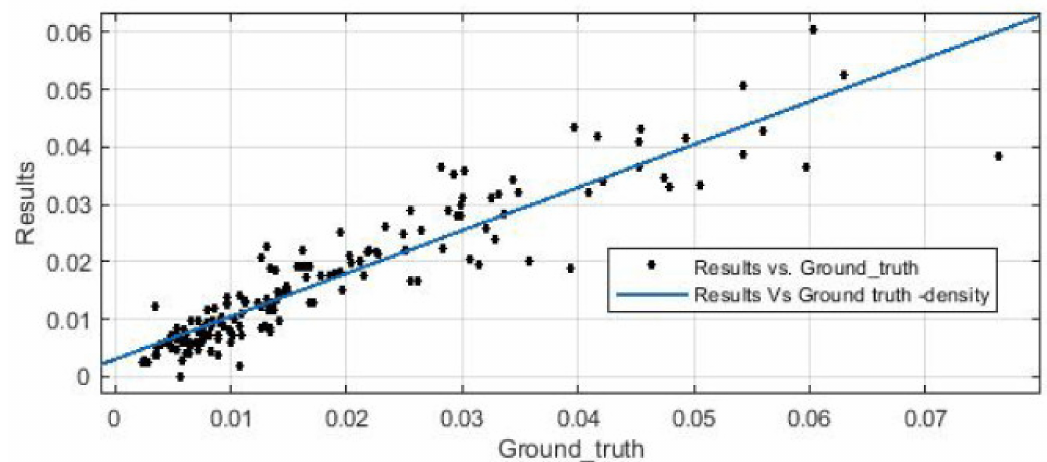
Figure 11. Density estimation for post-processing results vs. ground-truth annotations.